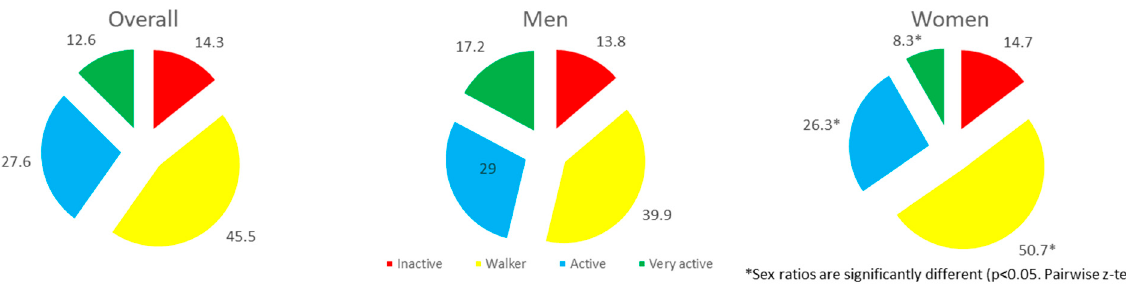
Figure A3. Self-perceived health of the Spanish population, according to their smoking status.